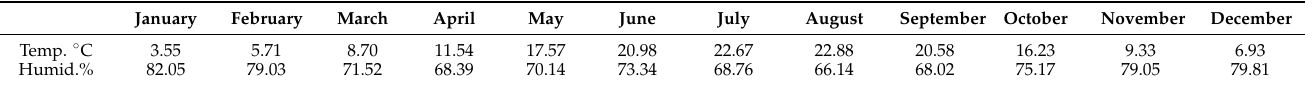
Table 1. Average temperature and humidity in 2019–2020 in the nearby region of the